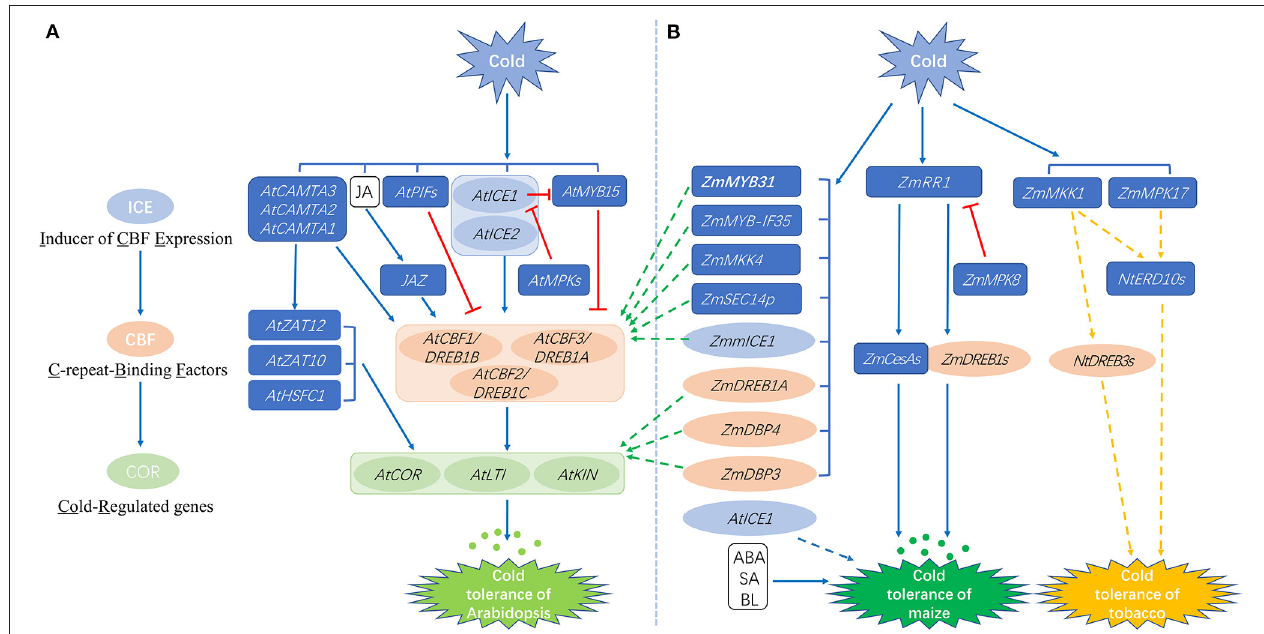
FIGURE 1 | Schematic diagram of the cold-responsive molecular networks in Arabidopsis (A) and maize (B) . The eight green dashed arrows that point to (A) from (B) indicate that the maize genes were functionally verified in transgenic Arabidopsis plants. The orange dashed arrows in (B) indicate that the maize genes were functionally studied in tobacco. The blue dashed arrow in (B) indicates that the Arabidopsis gene AtICE1 was transformed into forage maize. The colored ellipses represent molecular elements that belong to the ICE-CBF-COR pathway. Small dots represent osmotic substances. Brackets encompass genes with the same induction level. Straight and dashed arrows represent positive regulation, whereas lines ending with a bar represent negative regulation. At, Arabidopsis thaliana L.; Zm, Zea mays L.; Zmm, Zea mays ssp. mexicana L.; Nt: Nicotiana tabacum L.; CAMTA, Calmodulin-binding transcription activator; ZAT, Zinc-finger transcription factor; HSFC, Heat shock transcription factor C; JAZ, Jasmonate ZIM-domain; DREB, Dehydration responsive element binding factor; LTI, Low temperature induced; KIN, Cold inducible; MPK, Mitogen-activated protein kinase; SEC14P, Sec14-like protein; RR, Response regulator; DBP, Dehydration responsive element binding protein; CesA, Cellulose synthase; MKK, Mitogen-activated protein kinase kinase; ERD, Early response to dehydration; JA, Jasmonic acid; ABA, abscisic acid; SA, Salicylic acid; BL,